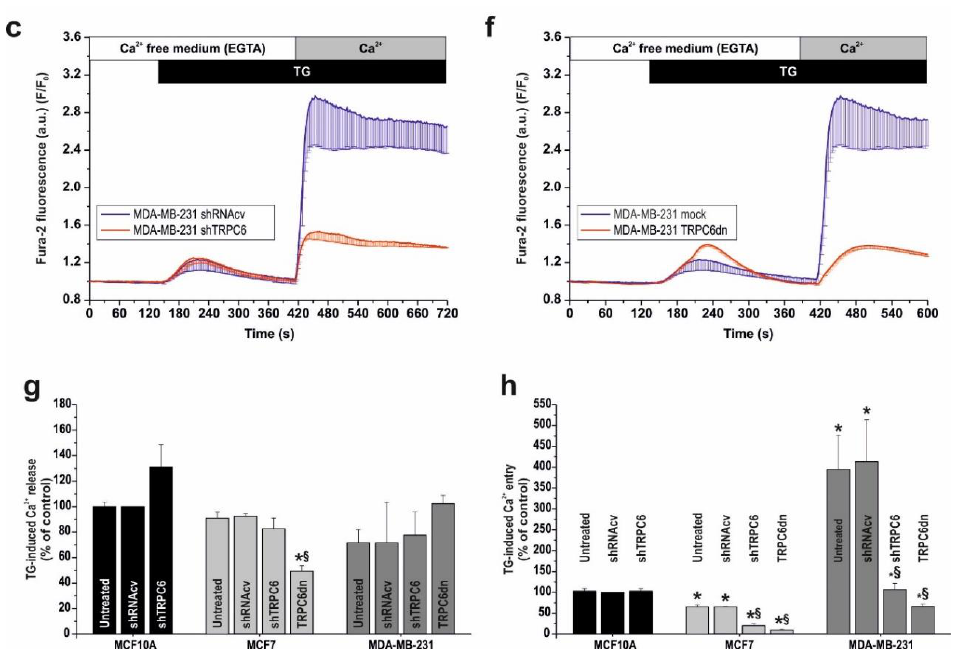
Figure 5. TRPC6 is required for store-operated Ca 2+ entry in breast cancer cell lines. ( a – c ) MCF10A, MCF7 and MDA-MB-231 cells were transfected with shTRPC6 or scramble plasmid (shRNAcv), as indicated. Forty-eight hours after transfection, fura-2-loaded cells were perfused with a Ca 2+ -free medium (100 µM EGTA added) and then stimulated with TG (1 µM) followed by reintroduction of external Ca 2+ (final concentration 1 mM) to initiate Ca 2+ entry. Data are mean ± SEM of 40 cells/day/3 - 5 days. ( d – f ) MCF7 and MDA-MB-231 cells were transfected with TRPC6dn mutant expression plasmid or empty vector (mock), as indicated. After 48 h cells were lysed and subjected to western blotting with anti-TRPPC6 antibody, followed by reprobing with anti- β -actin antibody for protein loading control ( d ). Molecular masses indicated on the right were determined using molecular-mass markers run in the same gel. ( e and f ) Forty-eight hours after transfection, fura-2-loaded cells were perfused with a Ca 2+ - free medium (100 µM EGTA added) and then stimulated with TG (1 µM) followed by reintroduction of external Ca 2+ (final concentration 1 mM) to initiate Ca 2+ entry. Data are mean ± SEM of 40 cells/day/3 -5 days. Bar graphs represent TG-induced Ca 2+ release ( g ) and entry ( h ) in MCF10A, MCF7 and MDA-MB-231 cells untreated or transfected with the indicated plasmids. Data are expressed as mean ± SEM and presented as percentage of control (MCF10A cells treated with scramble plasmid). * represents p < 0.05 as compared to scramble-treated MCF10A cells. § represents p < 0.05 as compared to the same cell line transfected with shRNAcv.